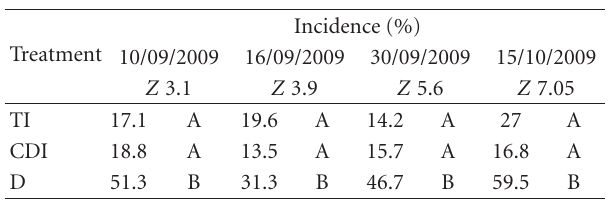
Table 2: Incidence (%) of foliar disease onset for total irrigation (TI), irrigation with controlled deficit (CDI) and dry (D) wheat at various phenological